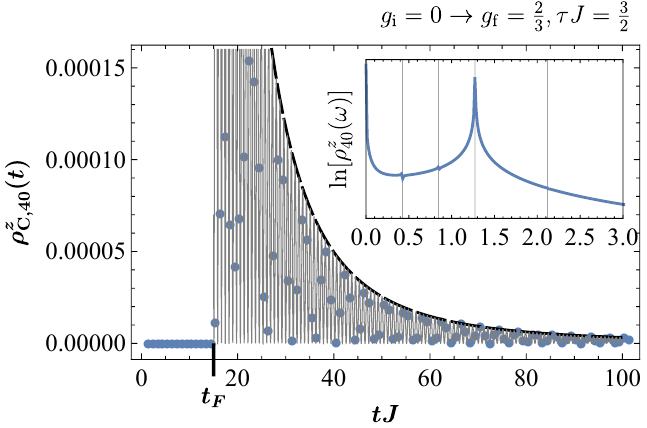
Figure 7: Connected two-point correlation function in the transverse direction for a linear quench. The full line is the stationary phase approximation result, the dashed line is the t − 3 envelope. The time scale at which correlations set in is indicated by t of the oscillations demonstrating a pronounced peak at 2 ( ω − ω ) , 4 ω the frequencies 2 ( ω , 4 ω π π 0 0